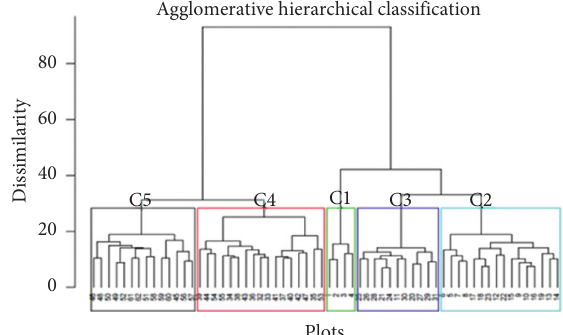
Figure 2: Dendrogram of the vegetation data obtained from hi- erarchical cluster analysis.